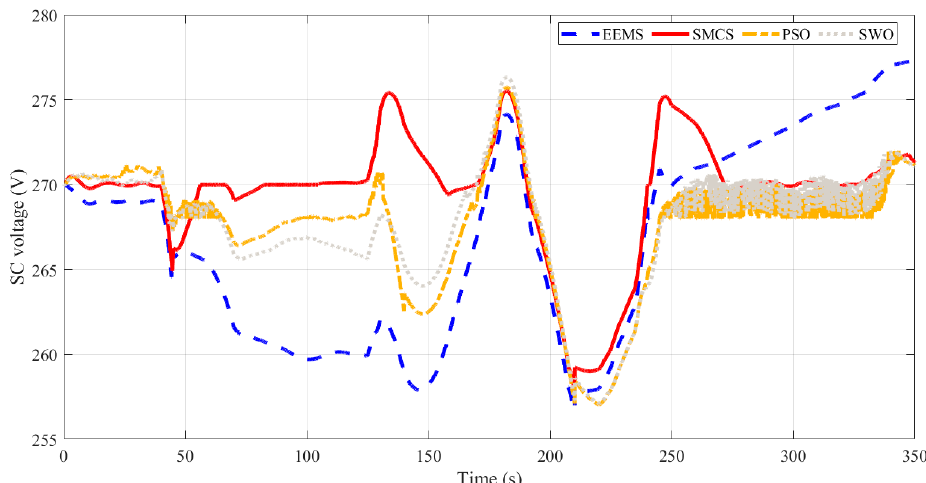
Figure 11. Dynamic produced power by different hybrid system components using WSO.